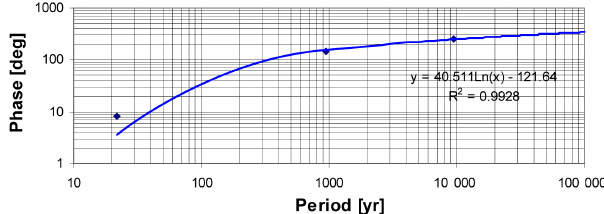
Figure B7. A model of phase between F (forcing) and TSI (sug- gested response) signals for different periods. The adjusted loga- rithmic model, which explains 99.5% of the variance, shows two trends, one to zero for short periods, and other, an asymptotic one, for long